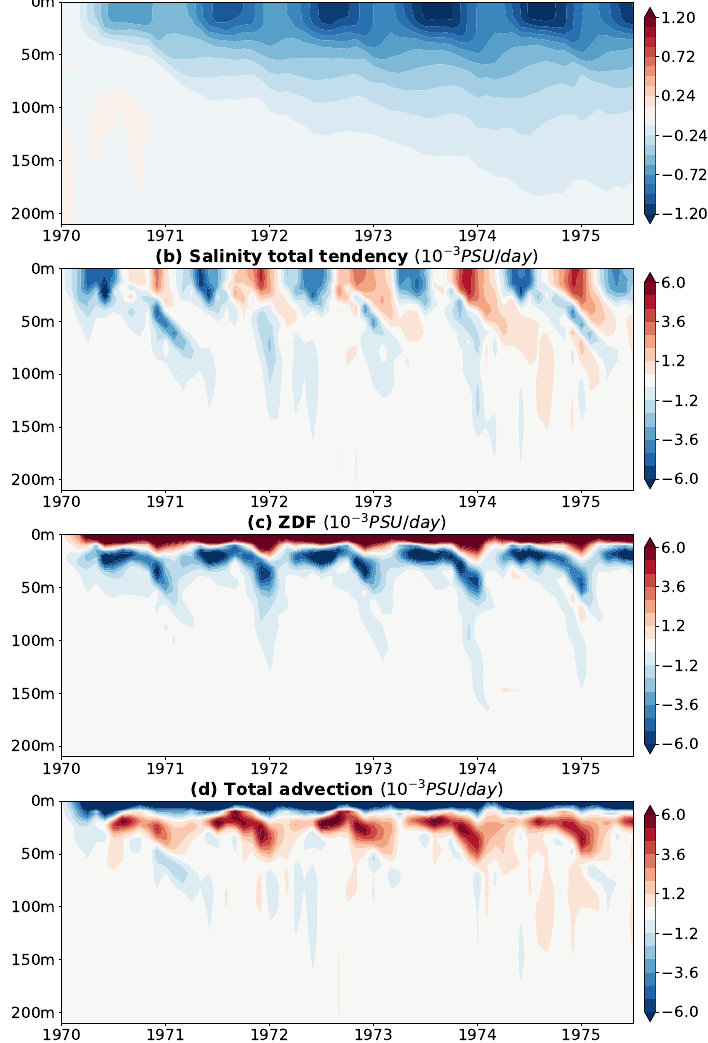
Figure 8. Depth-time distribution of the salinity ( a ) and of its main contributors averaged over the considered area: ( b ) total salinity tendency (10 − 3 PSU/day), ( c ) turbulent vertical diffusion of salinity (ZDF, 10 − 3 PSU/day), ( d ) Sum of horizontal and vertical salinity advections (10 − 3 PSU/day). The considered period is 1970–1975, that is, the five first years of